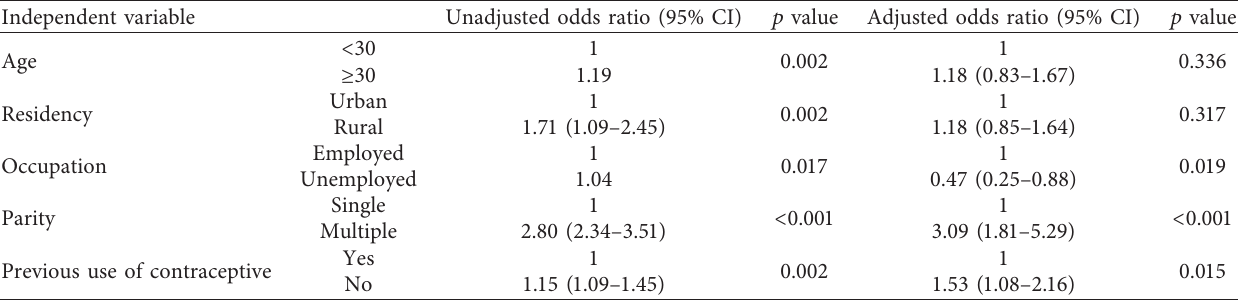
Figure 2: Percentage of anemia by severity among anemic pregnant women ( n � Table 3: Factors associated with anemia among pregnant women attending Bost Hospital for delivery in Helmand province, 2019: unadjusted and adjusted odds ratio.